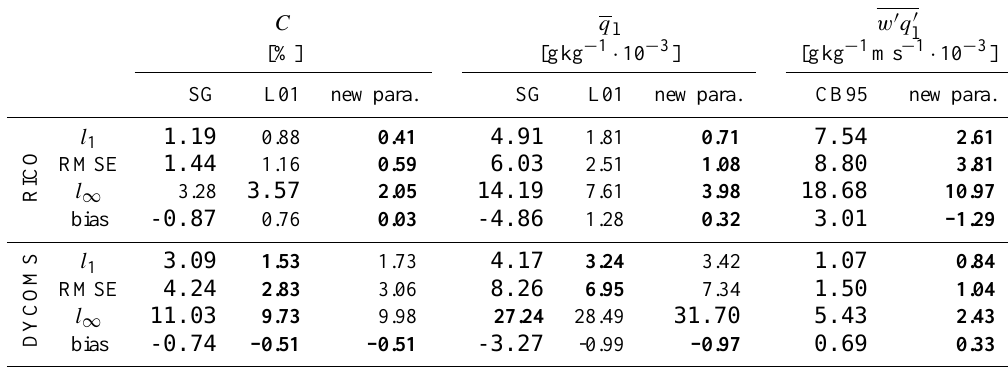
Table 3. Errors of the different parameterizations for the training data sets, RICO and